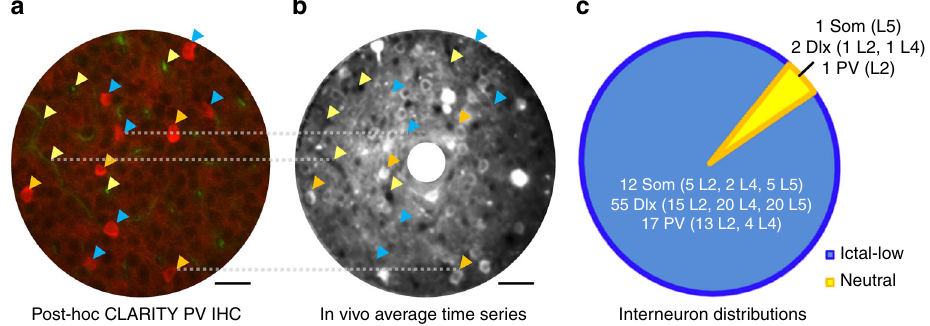
Fig. 5 Interneurons identi fi ed in vivo and ex vivo. a Unperfused, clari fi ed brain tissue allowed blood vessels to auto- fl uoresce in the green channel (yellow arrowheads), while PV + interneurons were immunostained and are shown in red (blue and orange arrowheads). Horizontal scale bar = 30 µ m. b Co- registration with blood vessels (yellow arrowheads labeling both in-plane and perpendicular vessels) from an in vivo average of a time series revealed PV + interneurons that were GCaMP6 + (orange arrowheads) versus GCaMP6- (blue). Horizontal scale bar = 30 µ m. c Combined with interneurons identi fi ed in vivo due to expression of tdTomato under Somatostatin-Cre (Som) or Dlx-5/6-Cre (Dlx) drivers, the majority of identi fi ed interneurons were ictal-low in